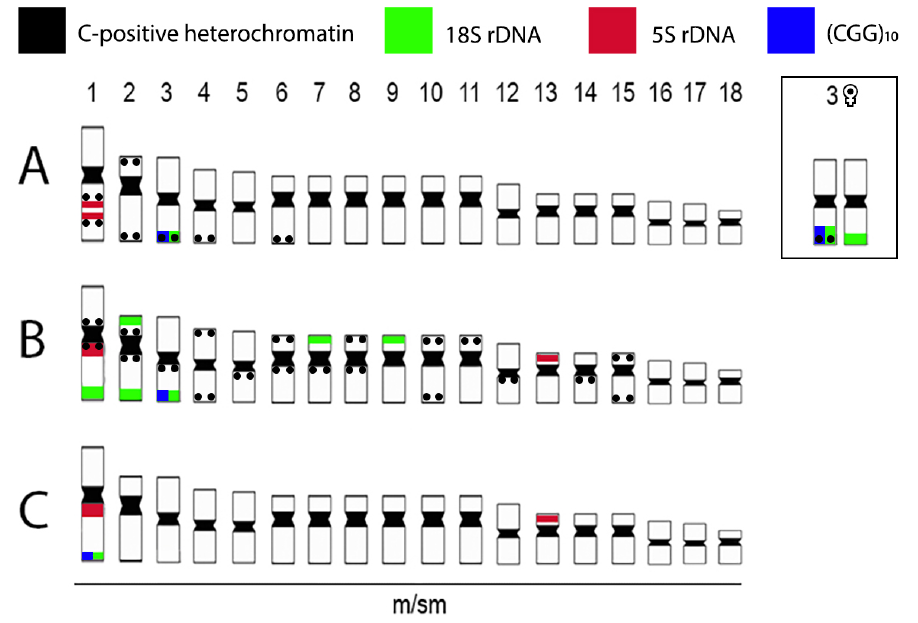
FIGURE 6 | Representative idiograms of L. bimaculata ( A ); L. melanoguttata ( B ) and L. minuta ( C ) highlighting the distribution of the 18S (green) and 5S (red) rDNA sequences; (CGG)n microsatellite (blue) and C-positive heterochromatin (black): Data for L . bimaculata and L. melanoguttata are from Sassi et al.